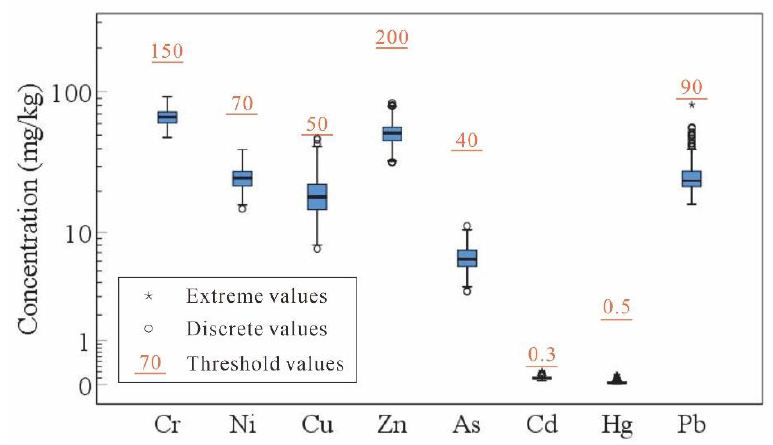
Figure 5. Box plot of heavy metal contents in surface soil. Table 9. Values of P i , I geo , E i , and RI.